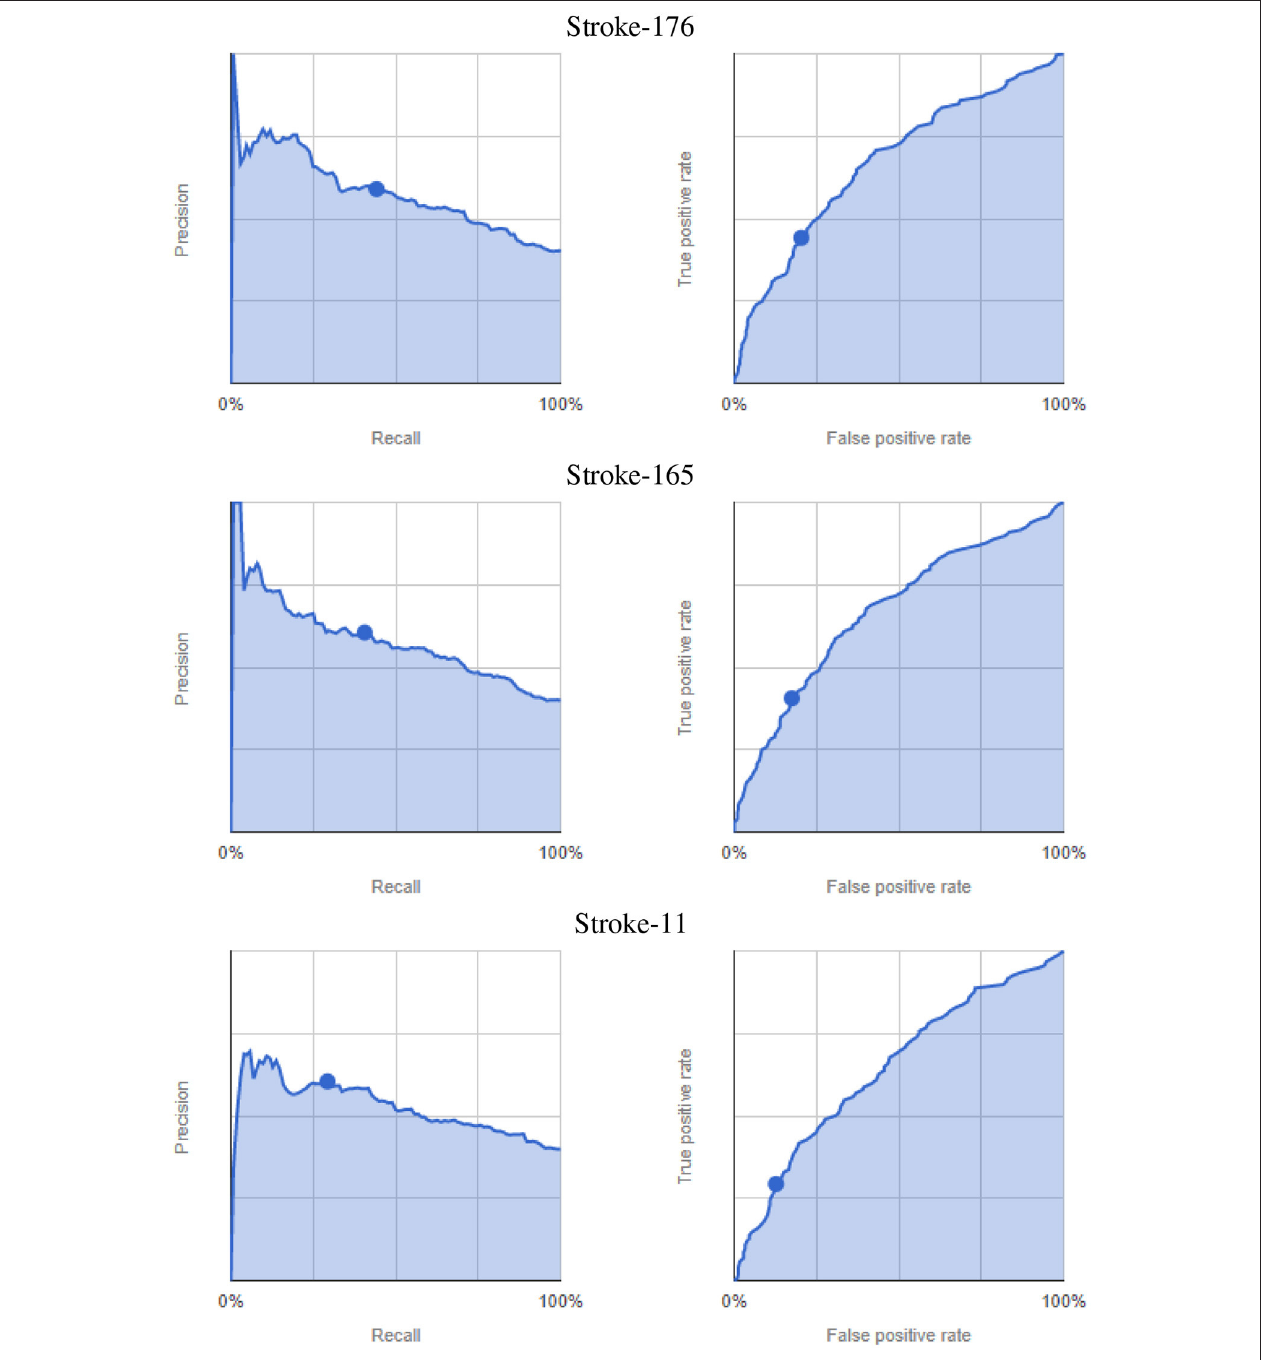
FIGURE 11 | AutoML-based classification of cognitive test performance per feature subsets. Precision-recall curves (left) and ROC curves (right), dots indicate the default 0.5 score threshold set by the framework.